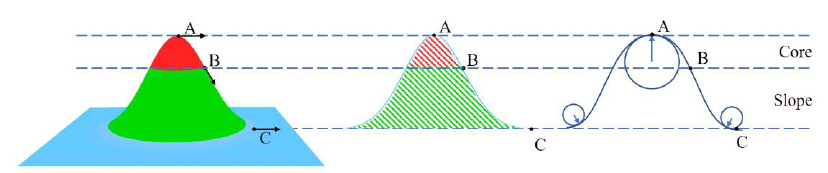
Figure 4. Stockpile extraction from point clouds based on bi-directional curvature [5].